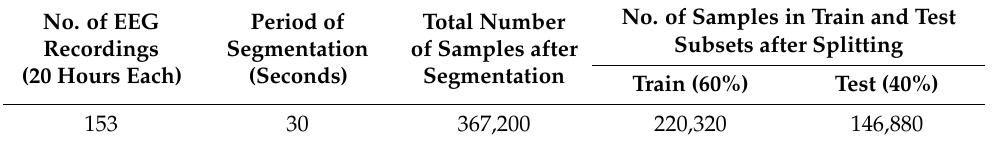
Table 1. The dataset